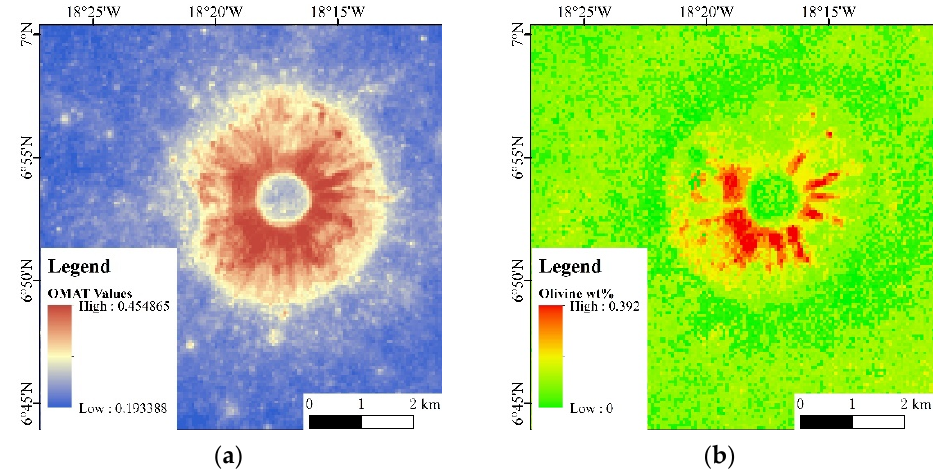
Figure 10. Mineral maps of the OMAT and olivine of Copernicus H. ( a ) OMAT in Copernicus H; ( b ) Olivine values on Copernicus H.